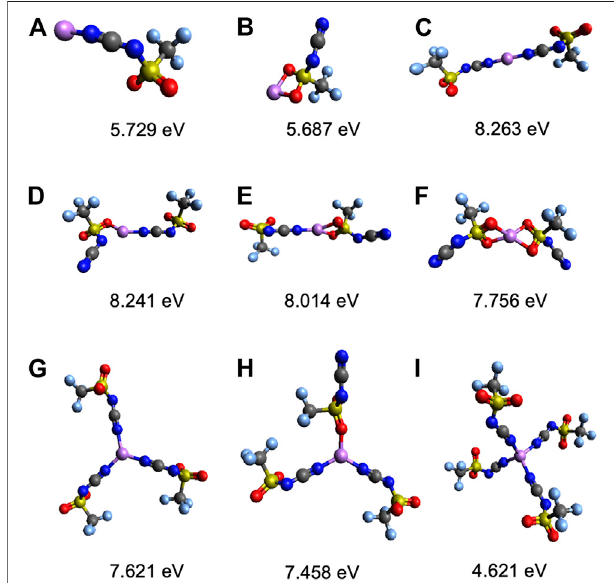
FIGURE 3 | Geometry optimized structures and calculated integral energies, E D , of Li solvates with [CTFSI] for the number of coordinating anions of 1 (A,B) , 2 (C – F) , 3 (G,H) , and 4 (I) . The atom color code is as follows: red (oxygen), blue (nitrogen), yellow (sulfur), gray (carbon), purple (lithium), and light blue ( fl